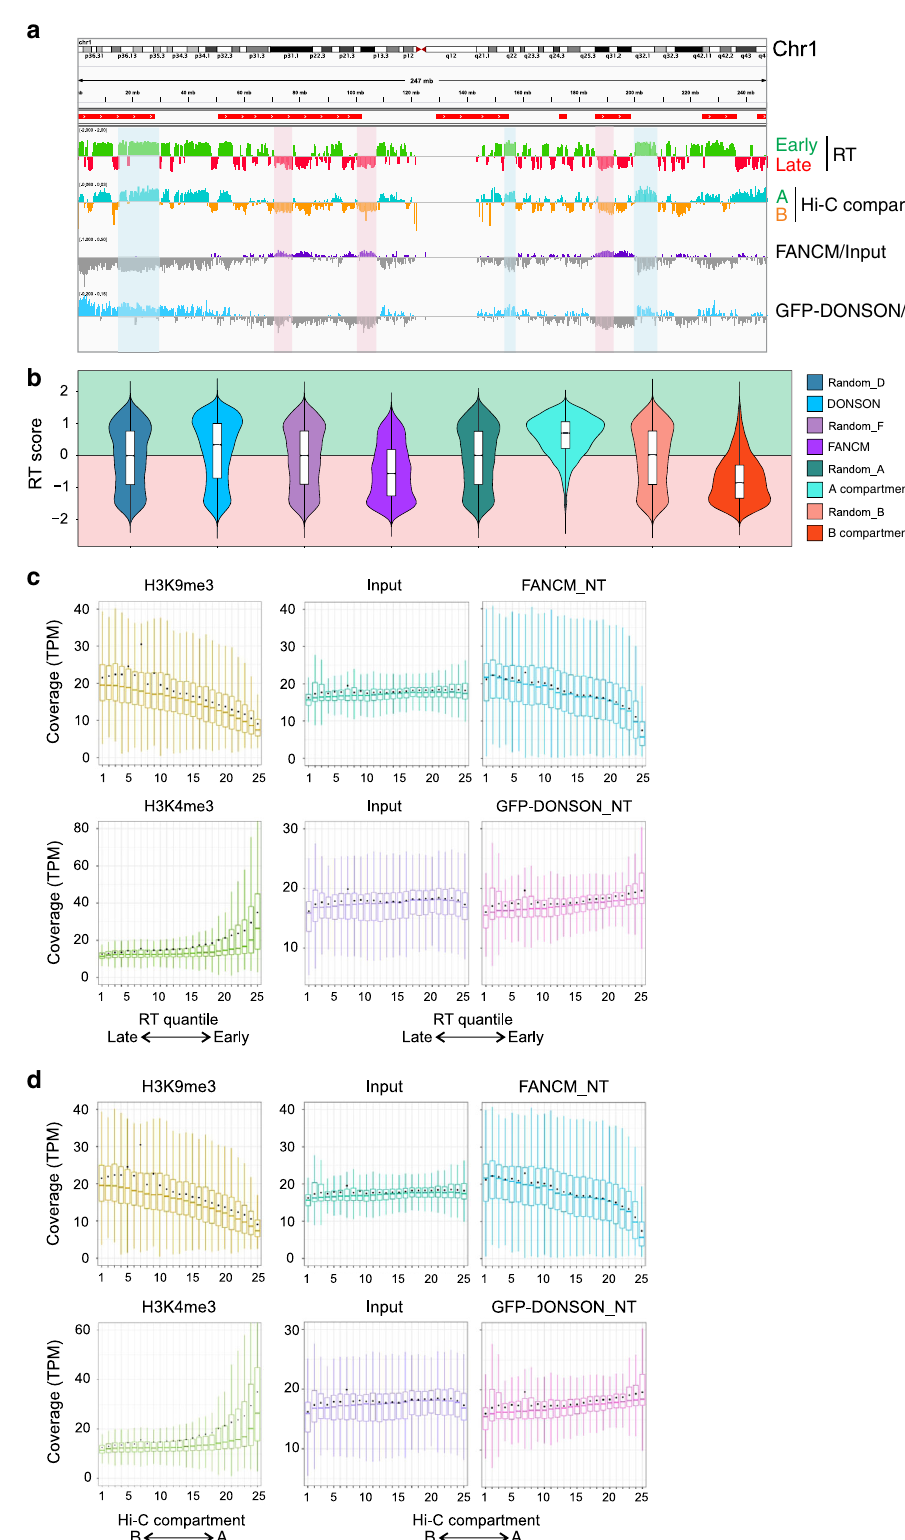
Cells, cell culture, transfection . HeLa CCL-2 and RPE1 (ATCC) cells were maintained in DMEM (Gibco) supplemented with 10% fetal calf serum (Gibco), μ g/ml Hygromycin B (Invitrogen), and 5 μ g/ml Blasticidin (Gibco). HeLa-Flp-In T-REx cells stably transfected with pcDNA5/FRT/TO-EGFP expressing EGFP or EGFP-DONSON were induced by incubation with 1 μ g/ml doxycycline for 48 h.